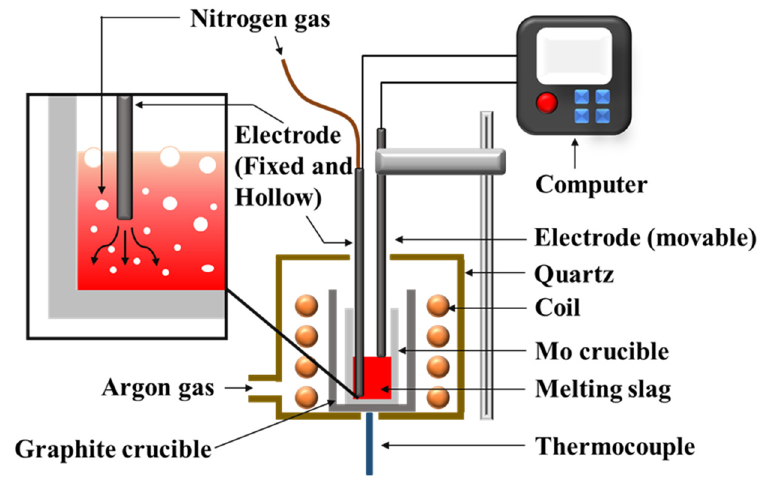
Figure 3. Schematic representation of the setup used for the foaming experiment.